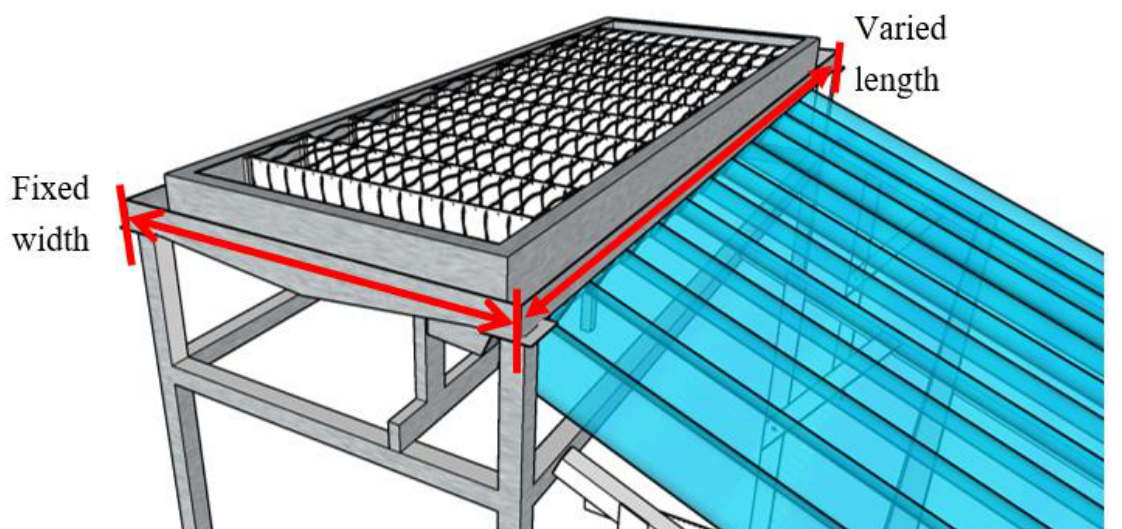
Figure 9. Recommended modification of the solar still’s basin dimension.